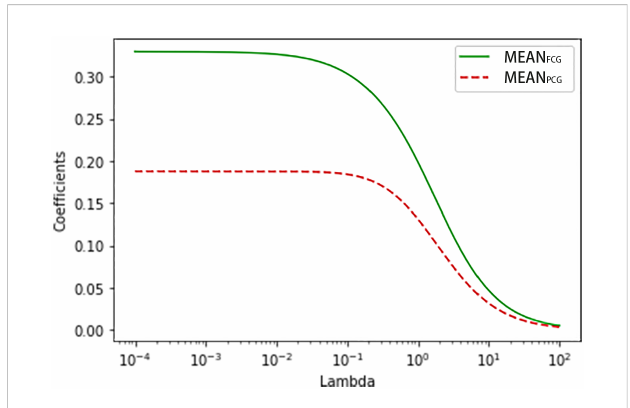
FIGURE 1 The ridge trace of the ridge regression model for predicting HbA1c with MEAN FCG and MEAN PCG